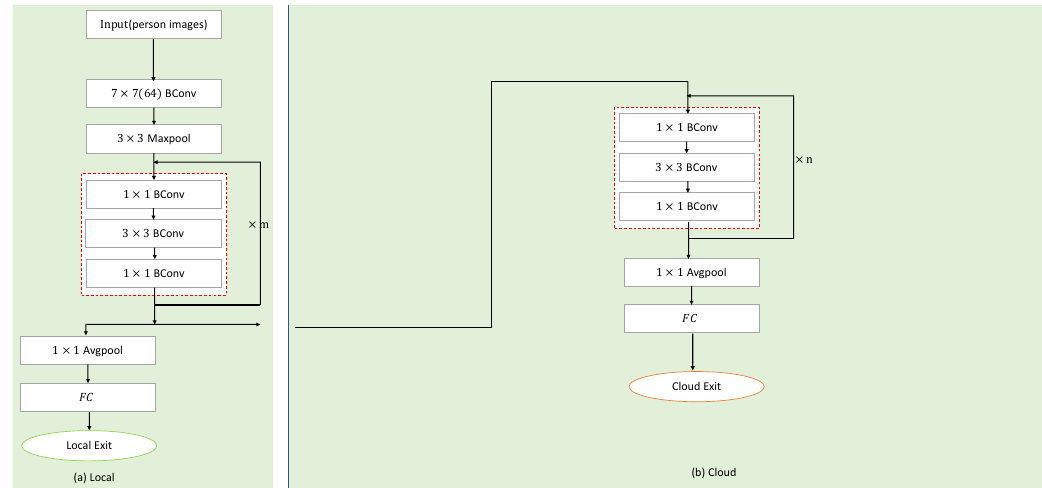
Figure 4. The segmented ResNet50 inference framework based on the end devices and the edge. The input is a pedestrian image. The left part ( a ) is the inference part on the end devices, and the right side ( b ) is the inference part on the